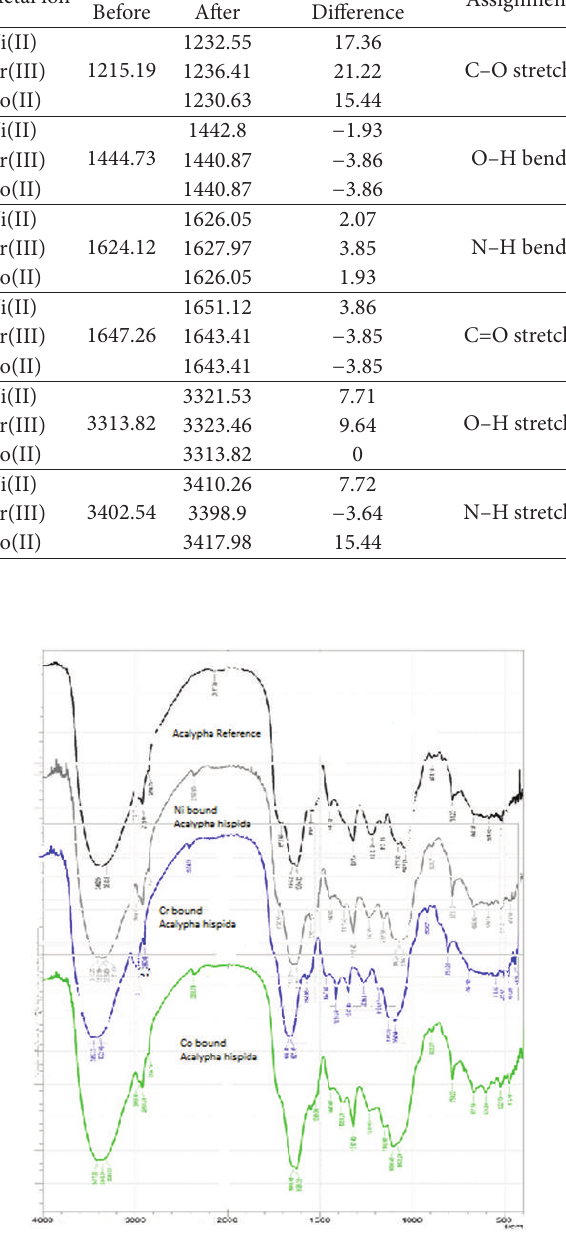
F 1: FTIR spectra of the free and metal-bound Acalypha hispida